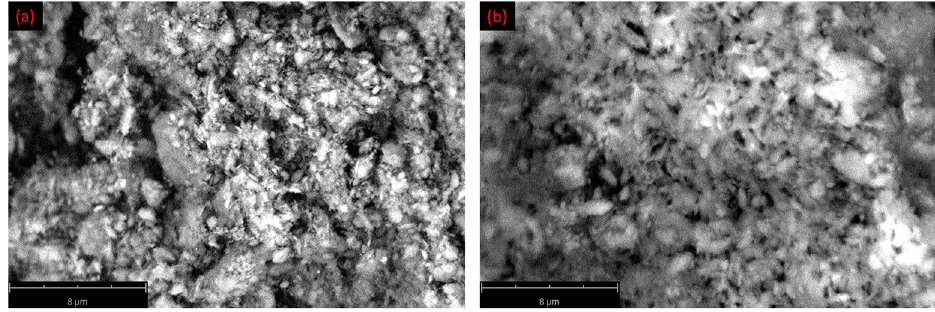
Figure 2. Scanning electron microscope images of ( a ) Void@RGO/GN and ( b ) S@RGO/GN. Table 1. Energy-dispersive x-ray results of Void@RGO/GN and S@RGO/GN.